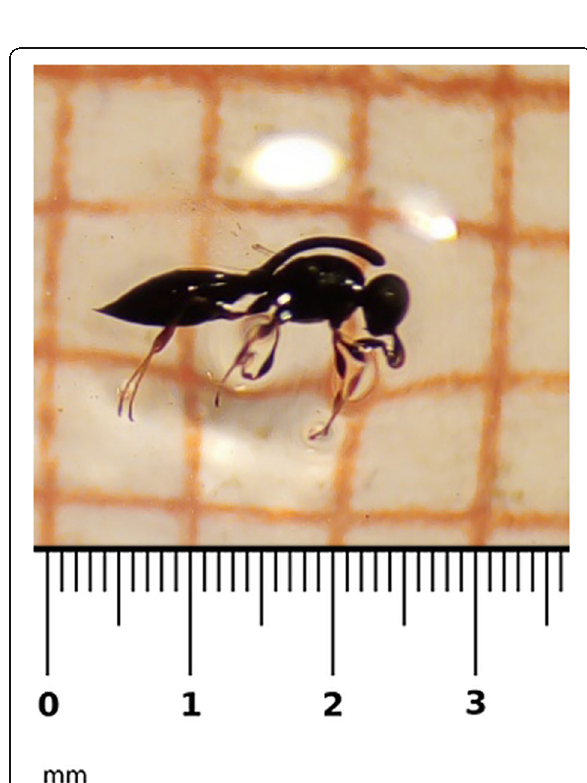
Fig. 3 Inostemma sp. (Platygastridae) (2